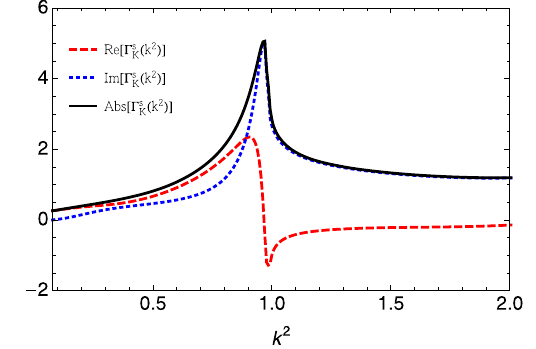
Fig. 2 The moduli of Γ s K K